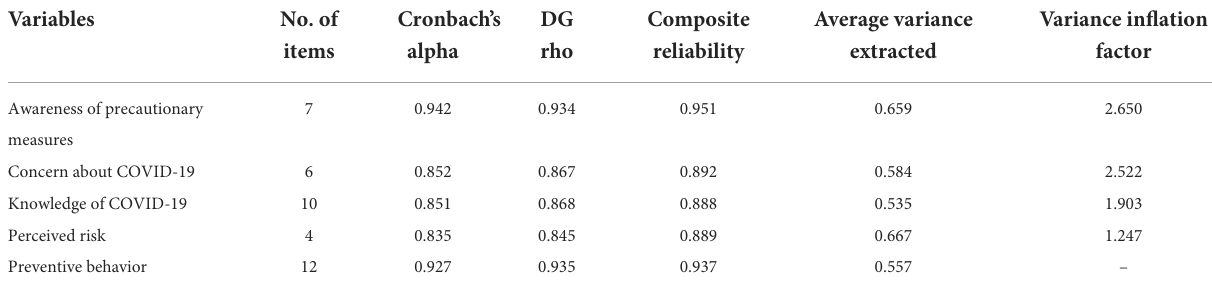
TABLE 9 Reliability